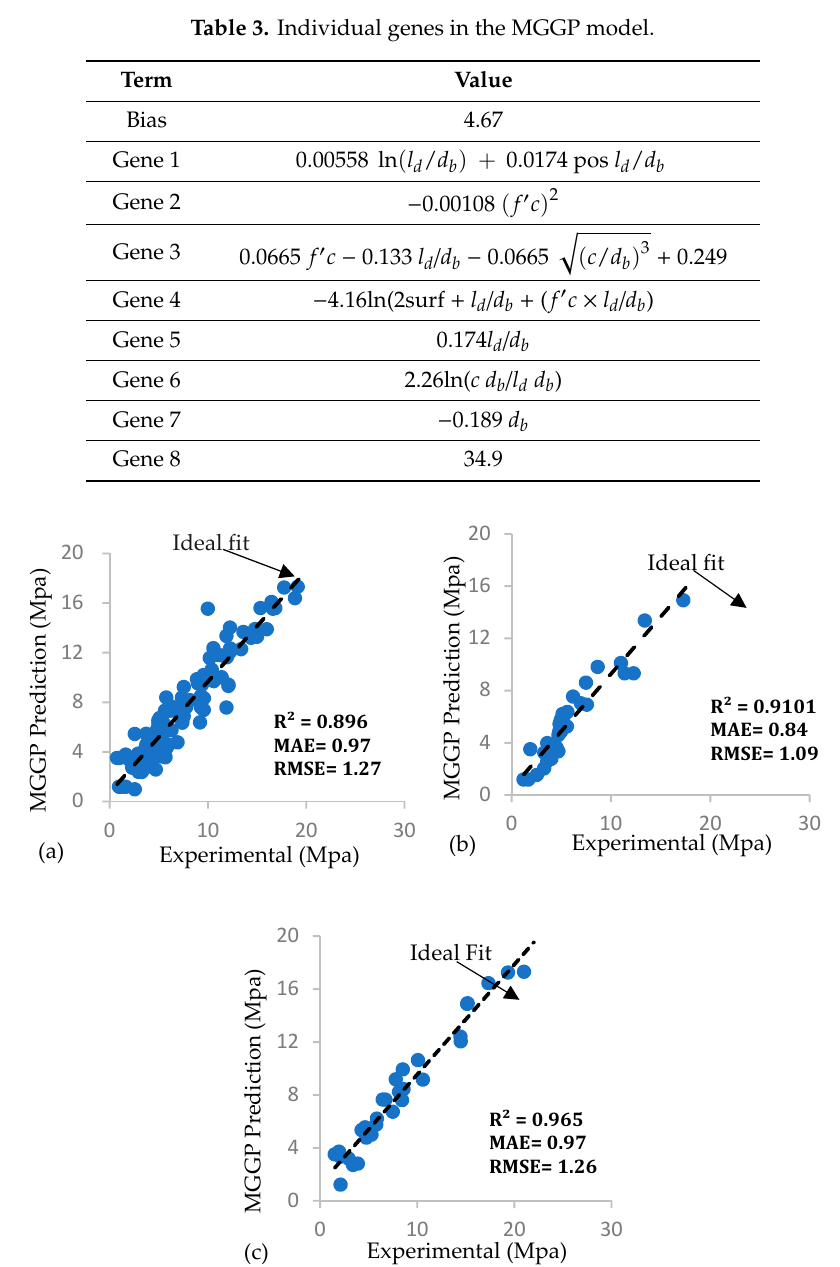
Figure 3. MGGP Prediction versus experimental bonding strength of ( a ) training data ( b ) testing data, and ( c ) validation data.